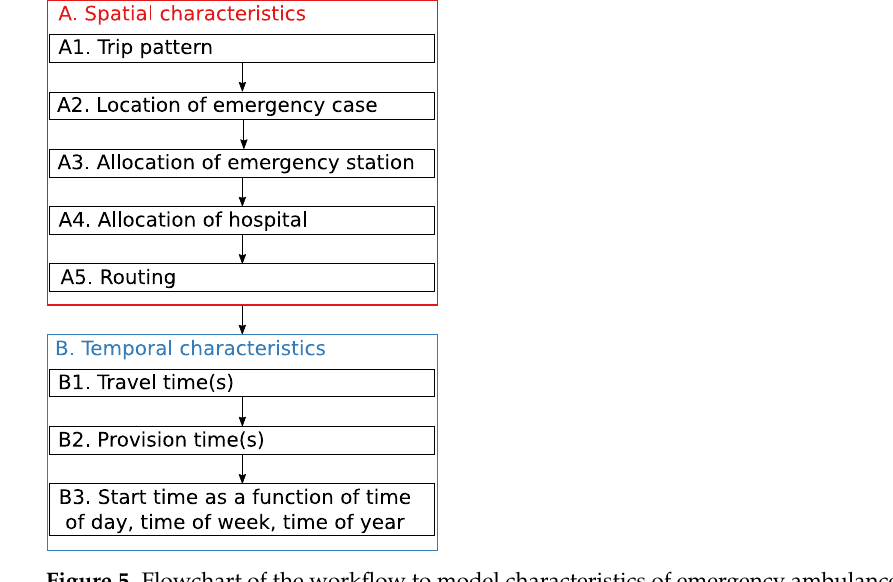
Figure 5. Flowchart of the workflow to model characteristics of emergency ambulance